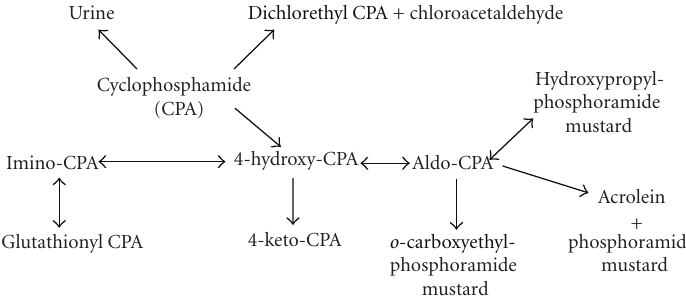
Figure 1: Cyclophosphamide metabolism.